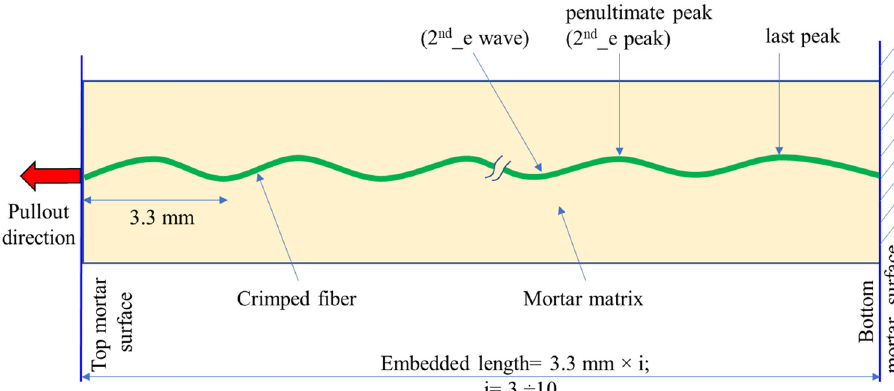
Figure 22: Schema of the pullout